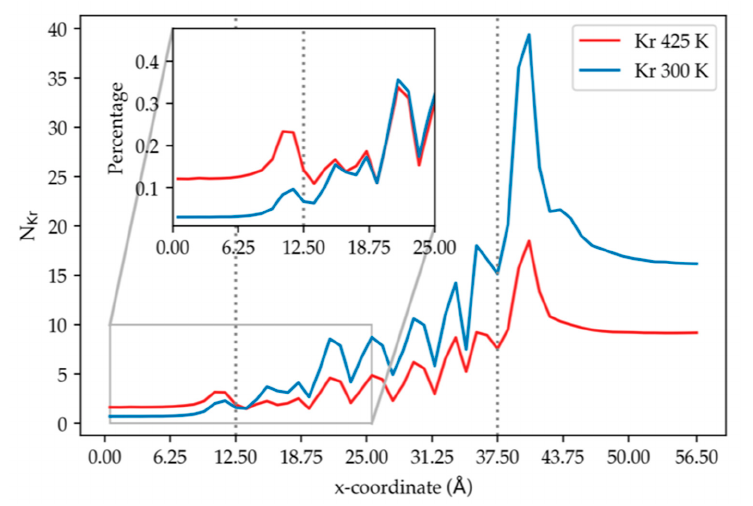
Figure 6. The density profile of krypton at different temperatures, normalized by the total number of atoms of the same species in the system, along the direction normal to the membrane surface, using results from simulation (2) and (3) at 150 atm. The dashed vertical lines correspond to the membrane edges.